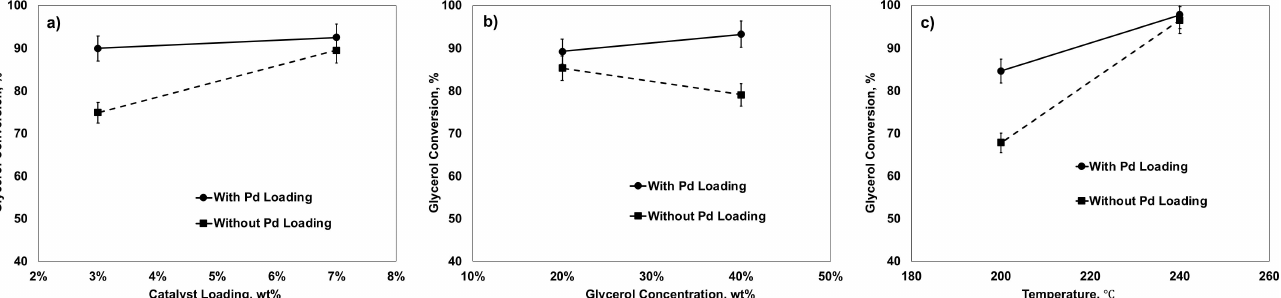
Figure 10. Two-factor interactions on the glycerol conversion. ( a ) Catalyst loading and Pd loading (BD); ( b ) glycerol feed concentration and Pd loading (CD); ( c )Temperature and Pd loading (AD), error margin: 95% confidence